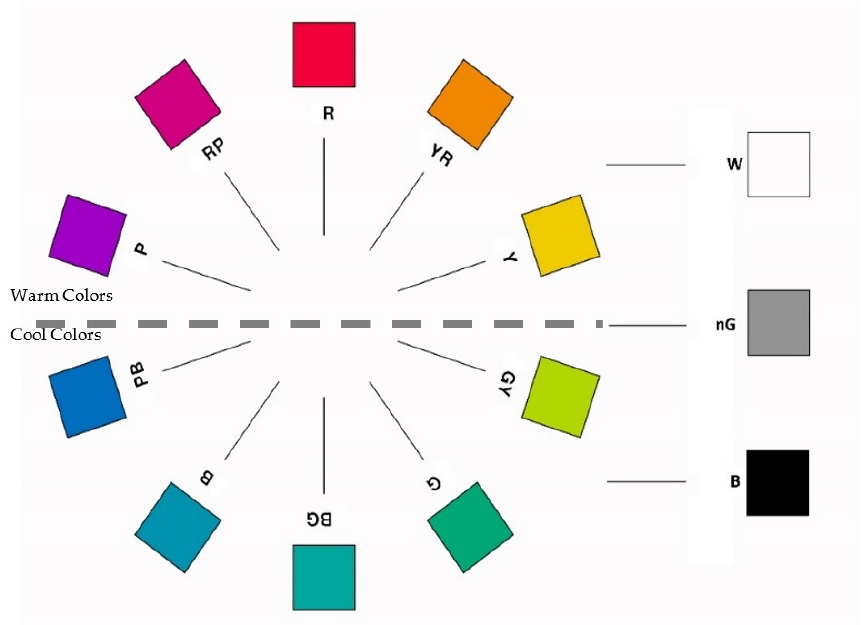
Figure 2. Palette of ten essential and three achromatic colors (source: authors, based on the Munsell system-licensed file under the Creative Commons Attribution 3.0 Unported license, 2021).